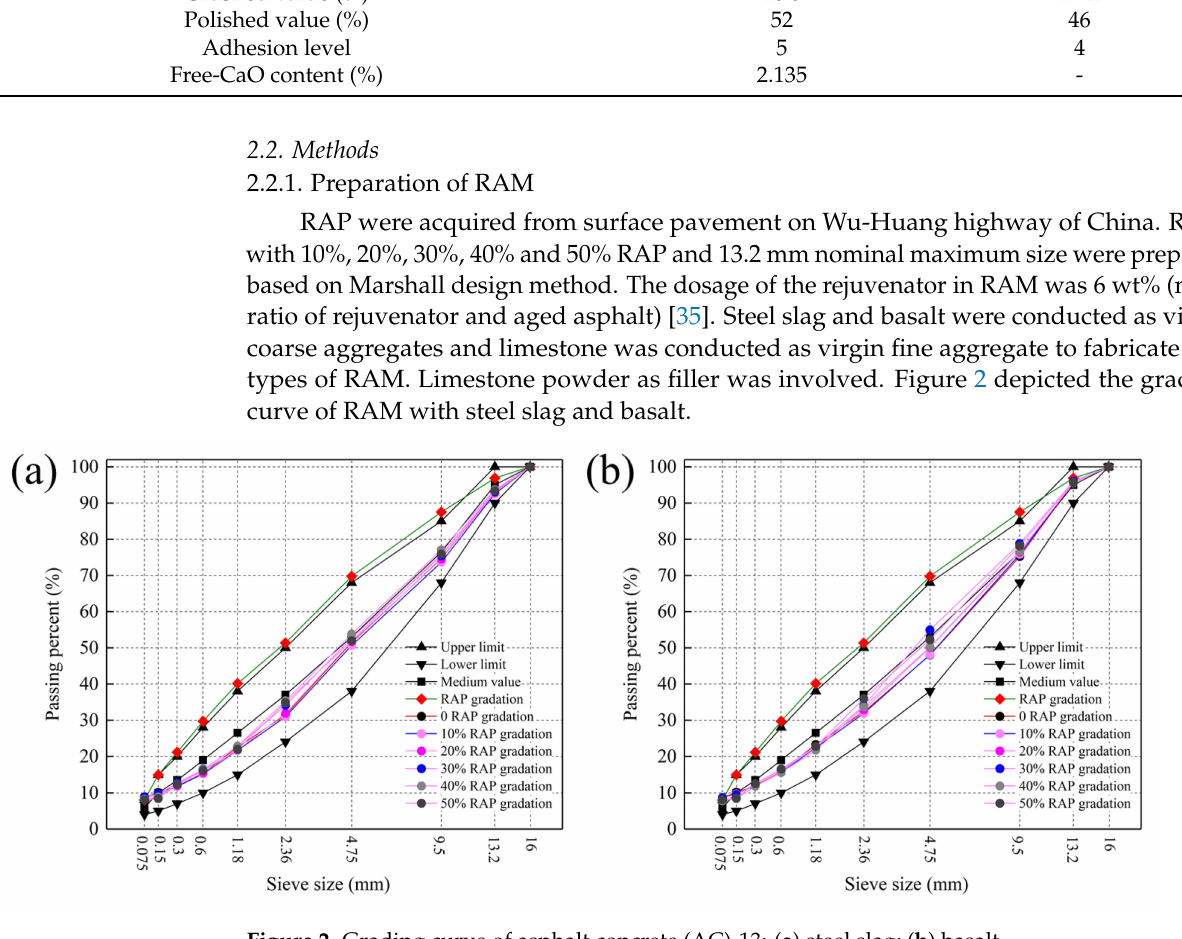
Figure 2. Grading curve of asphalt concrete (AC)-13: ( a ) steel slag; ( b )